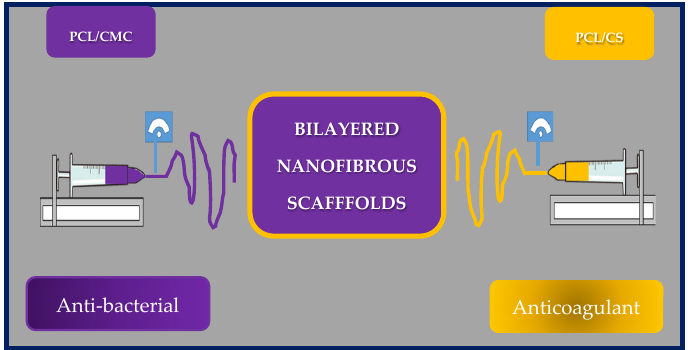
Figure 20. Schematic representation of the manufacture of asymmetric two-layer scaffold by co- electrospinning of poly(e-caprolactone) and chitosan (PCL/CS) and poly(e-caprolactone) with carboxymethylchitosan (PCL/CMC) scaffolds. Bibliography consulted [185].